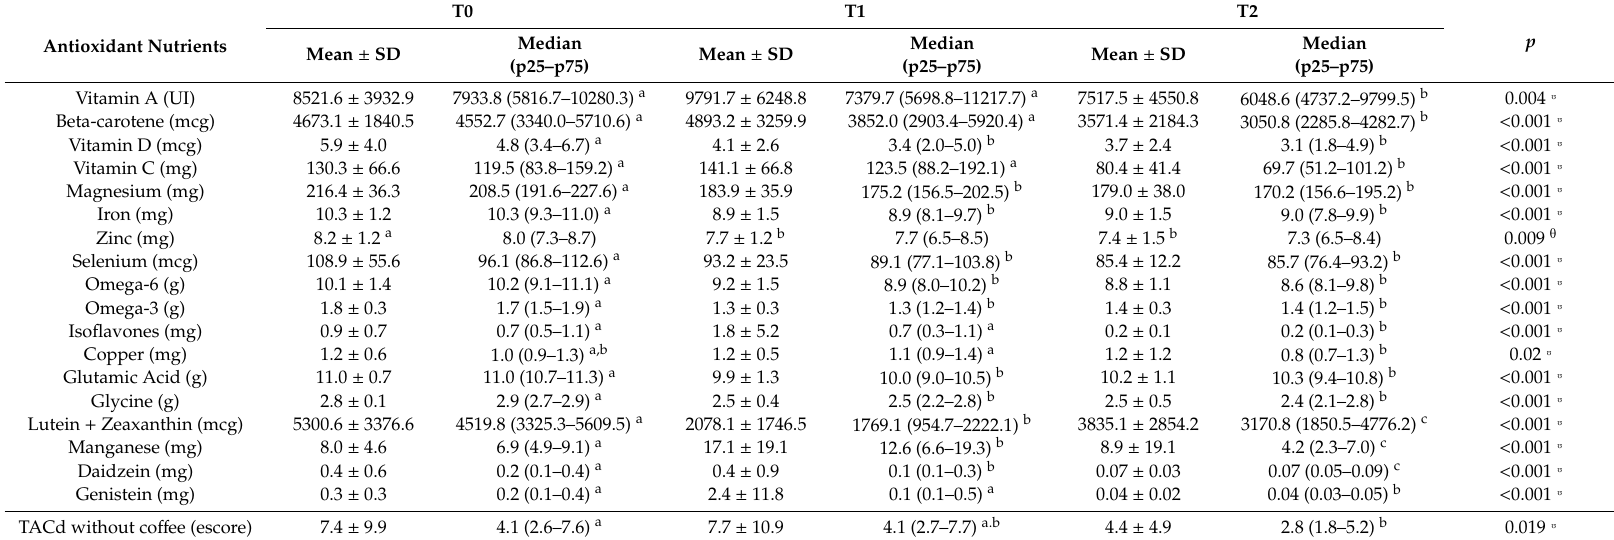
Table 3. Nutritional antioxidant profile of women with breast cancer on chemotherapy at a university hospital in Uberl â ndia, MG, Brazil, 2014–2015 ( n = 55).